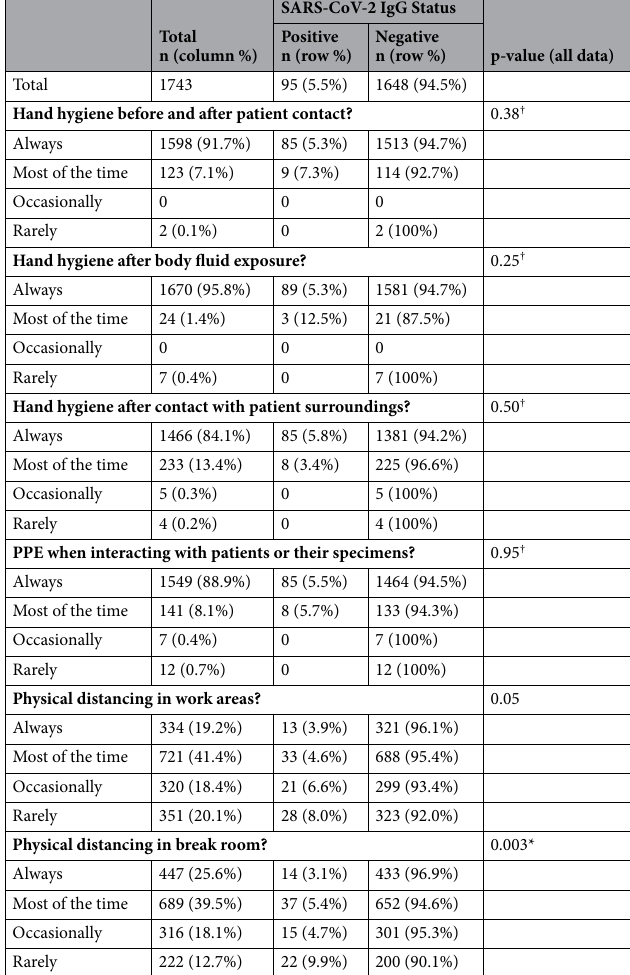
Table 4. Infection prevention and control measures by SARS-CoV-2 IgG status. † Fisher’s Exact Test, otherwise, Chi Squared. *Statistically significant when p-value < 0.05. Column percentages may not always add up to 100% due to missing data. Missing data ranged from